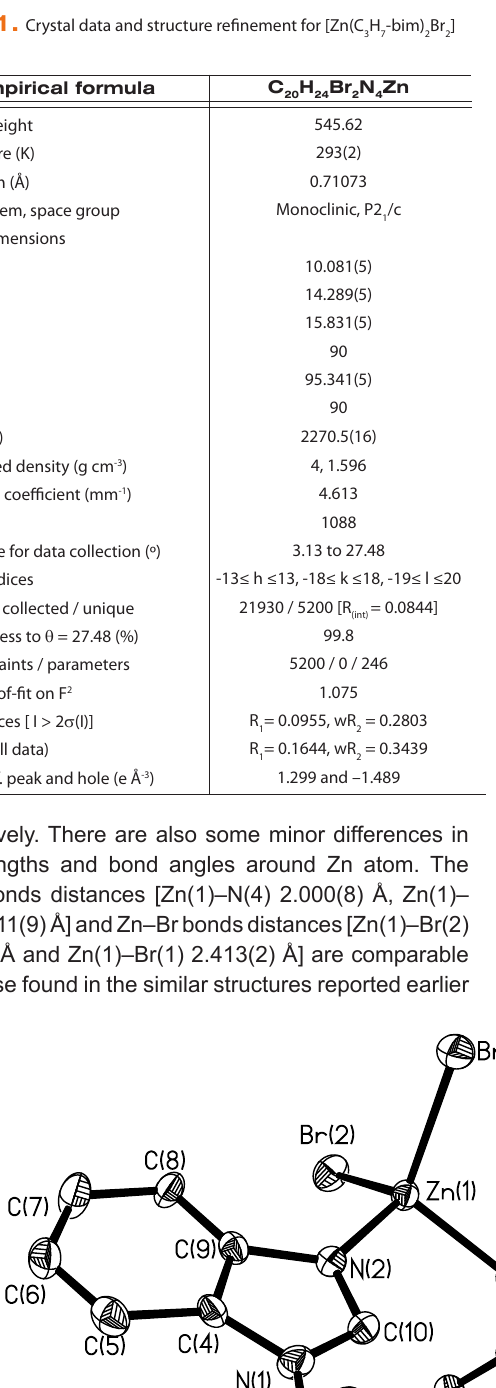
Table 1. Crystal data and structure refinement for [Zn(C